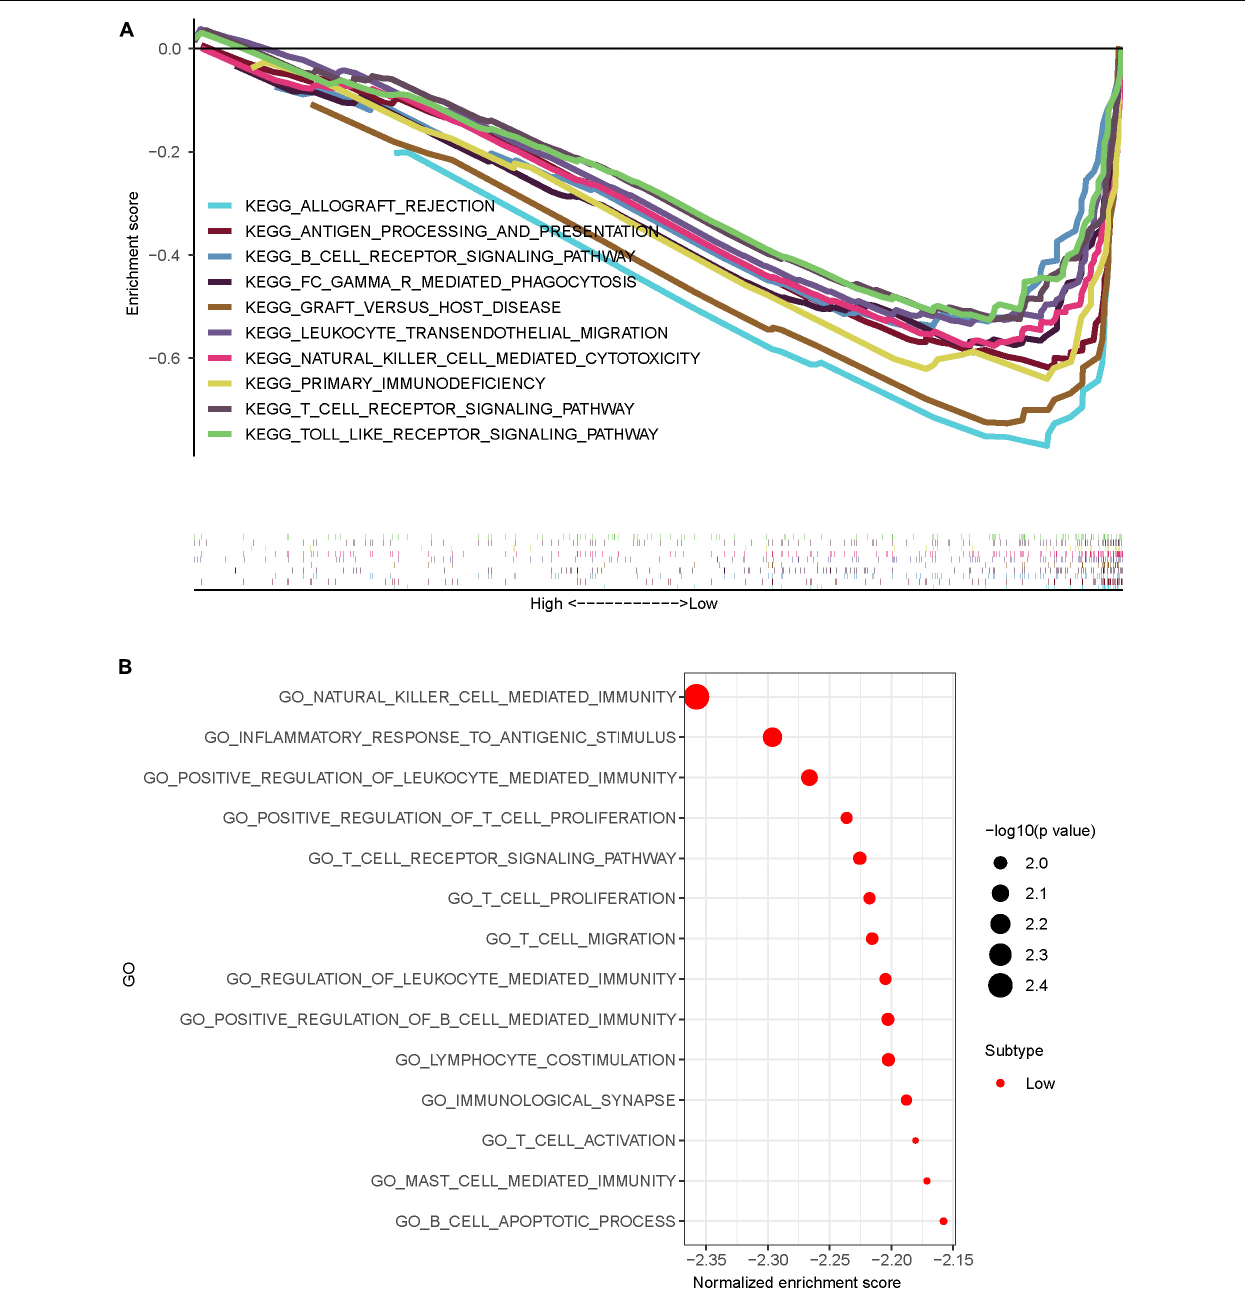
FIGURE 7 | Pathway and functional enrichment analysis of osteosarcoma in the high-risk and low-risk group osteosarcomas. (A) KEGG enrichment analysis of osteosarcomas showed that osteosarcomas in the low-risk group were mostly enriched in immune-related pathways. (B) GO enrichment analysis of osteosarcomas showed that osteosarcomas in the low-risk group were mostly enriched in immune-related functions.